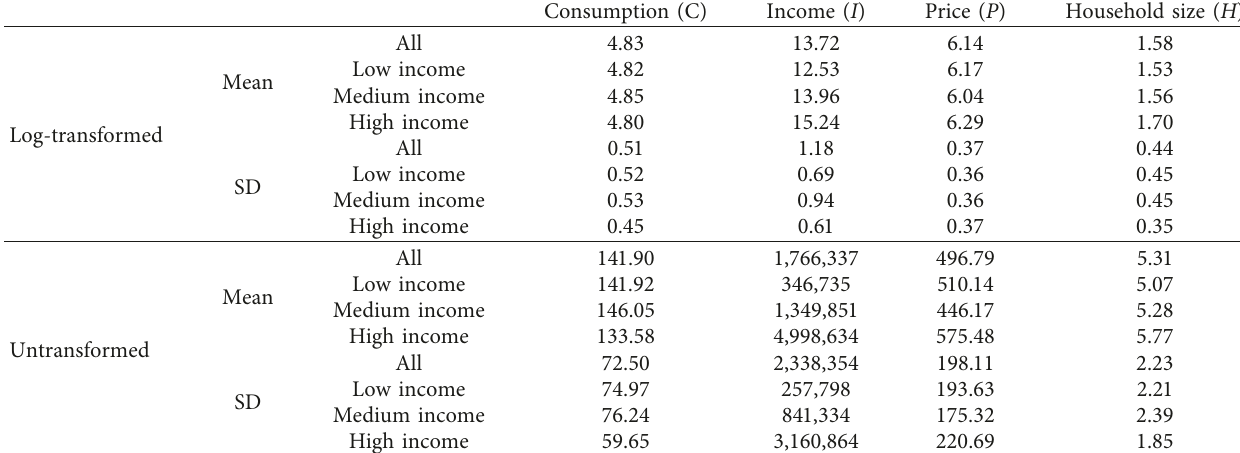
Table 1: Transformed and untransformed mean values and standard deviations (SD) of the data input used in the regression analysis for the total sample and distributed on income classes ( C , P , I , and H as defined in equation (1)).